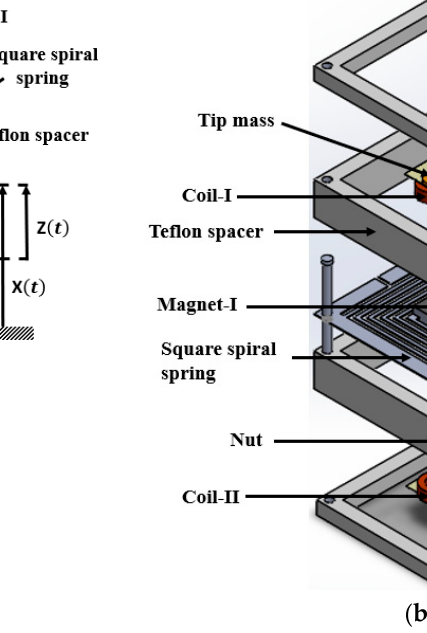
Figure 1. Hybrid insole energy harvester (HIEH): ( a ) vertical cross-section of the HIEH, ( b ) exploded view of the HIEH.